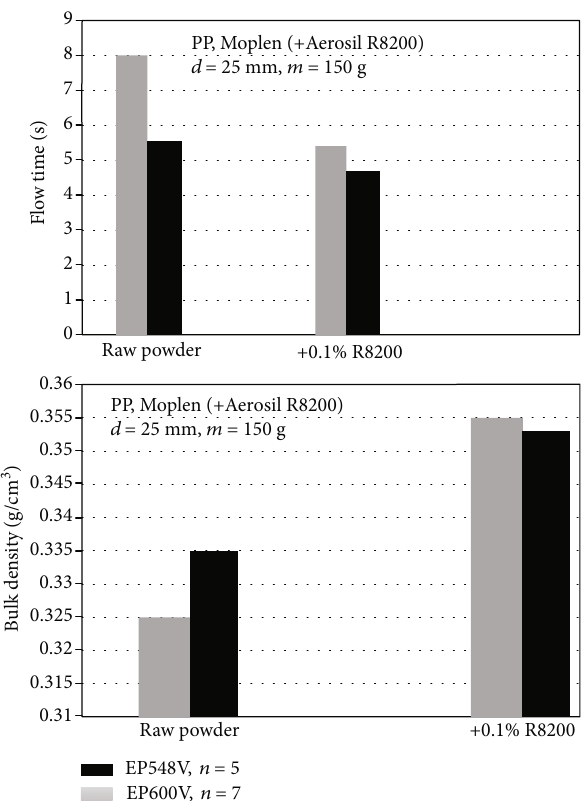
Figure 9: The e ff ect of fl ow and antistatic agents on fl ow characteristics and bulk density of PP powder [50].